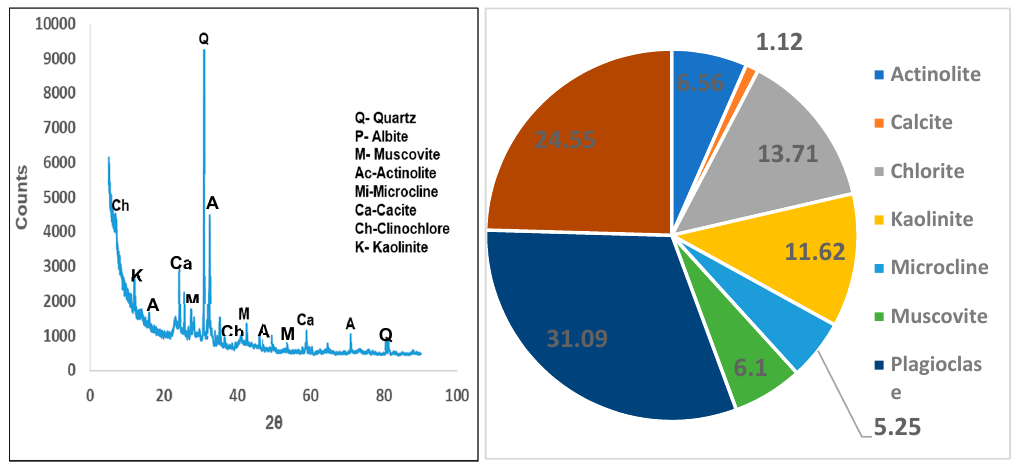
Figure 3. ( a ) X-ray diffraction spectrum ( b ) X-ray diffraction quantitative results of the activated clay.